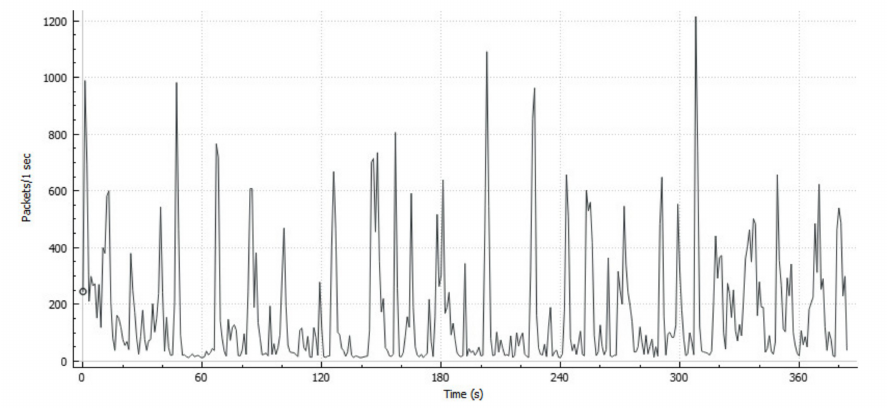
Figure 6. A diagram of the packet tra ffi c load when synchronizing a node with neighbors and